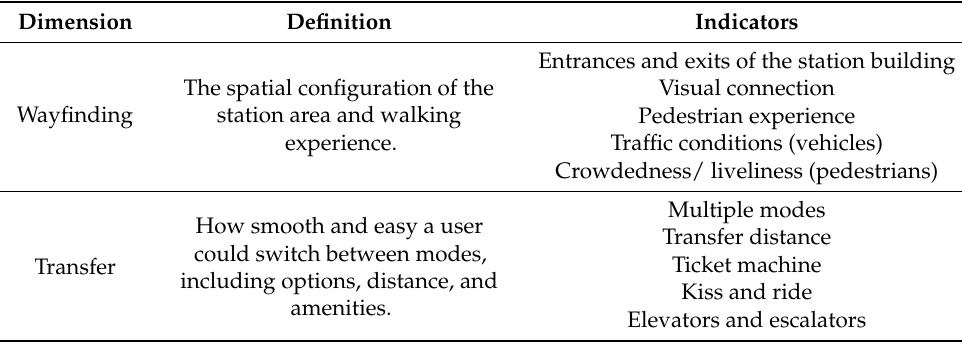
Table 1. Wayfinding and transfer indicators measured in